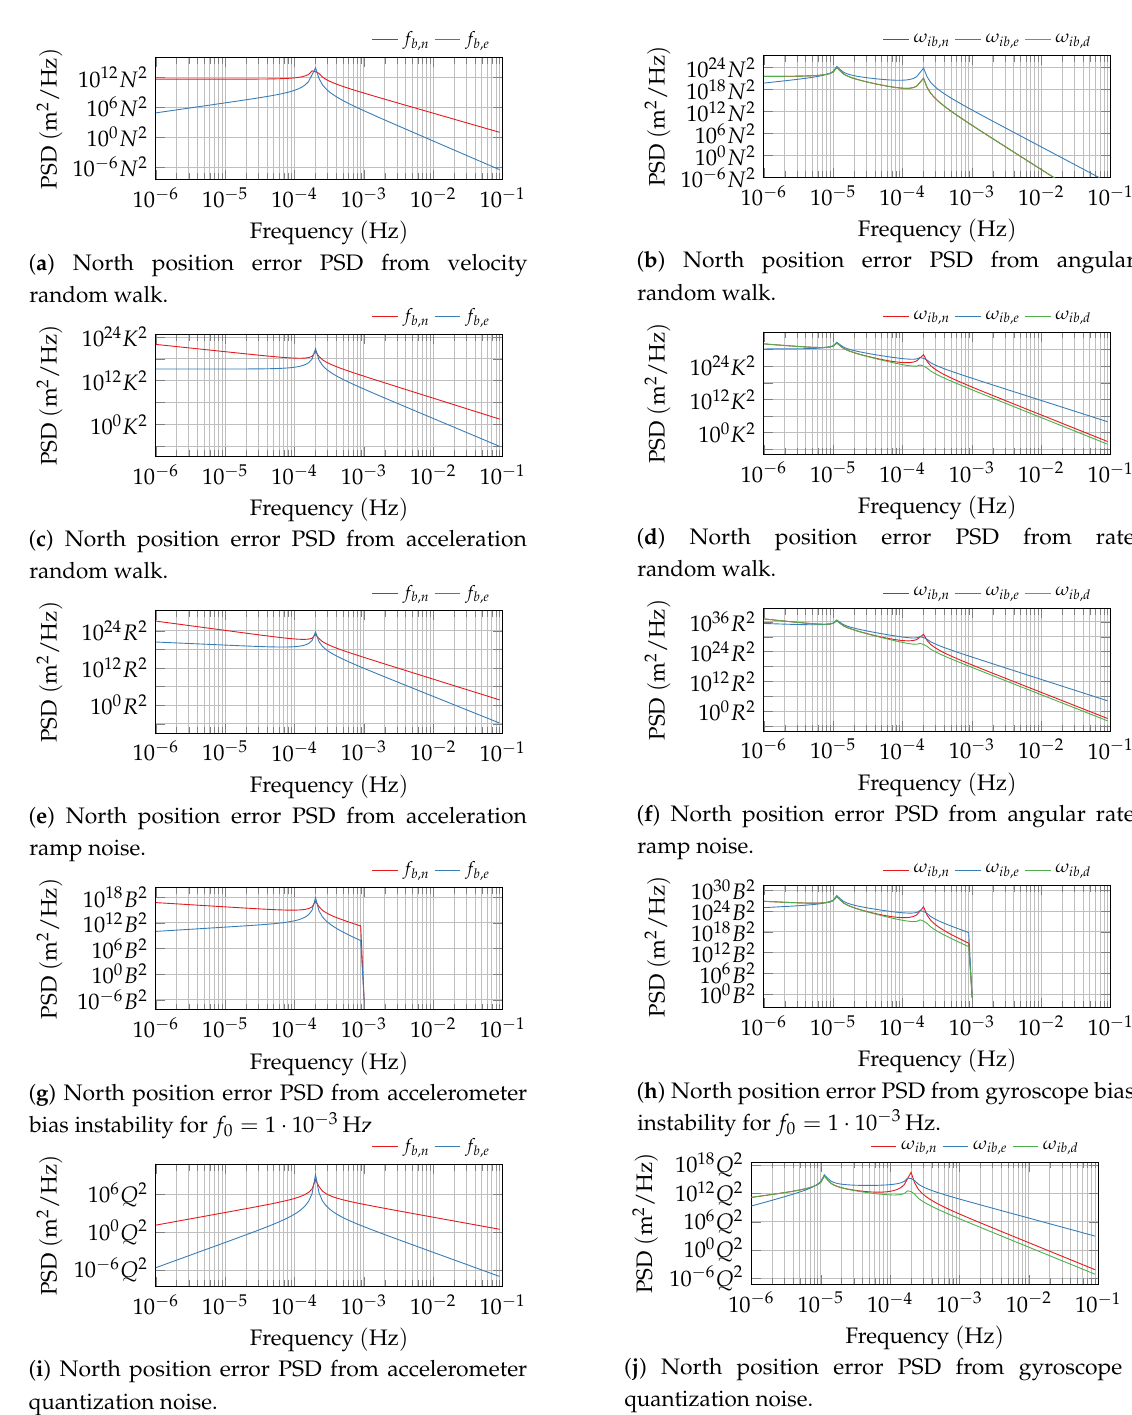
( j ) North position error PSD from gyroscope quantization noise.